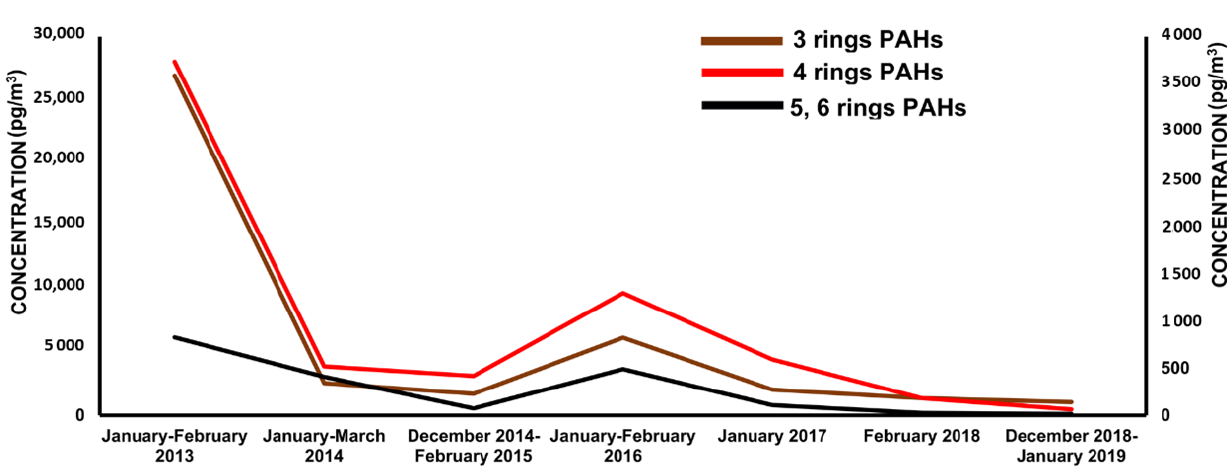
Figure 3. Temporal profile of sum of gaseous and particulate PAHs from 2013 to 2019 in Antarctica (4-, 5-, and 6-ring PAHs are represented on the right axis). Own elaboration using pollution PAHs data from Na et al. (2020) [62] .